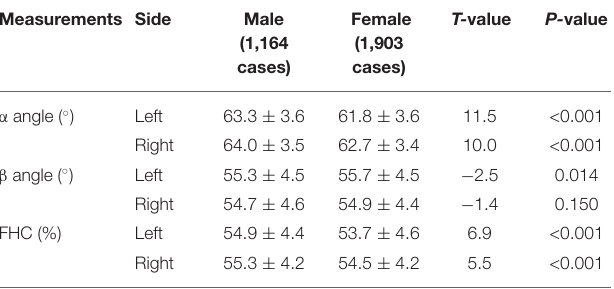
TABLE 2 | Comparison of α angle, β angle, and femoral head coverage of the hip between sexes in normal infants. Measurements Side